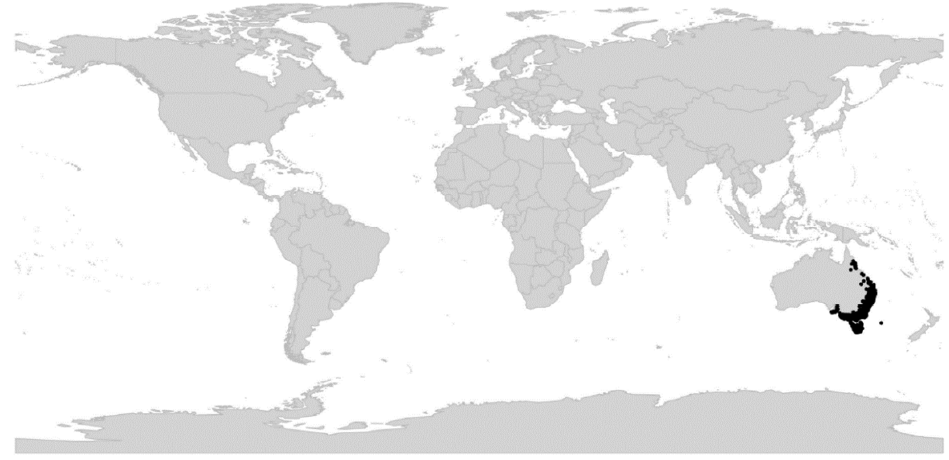
Figure 17. Global distribution of Viola sect. Erpetion . Discussion .—Phylogenetically, sect. Erpetion is an allo-octoploid lineage with two CHAM genomes and another two genomes in common with sect. Chilenium , indicating verged. There is no indication that this ancestral tetraploid Erpetion still exists. Section Erpetion is characterised karyologically by the secondary base chromosome number x’ =